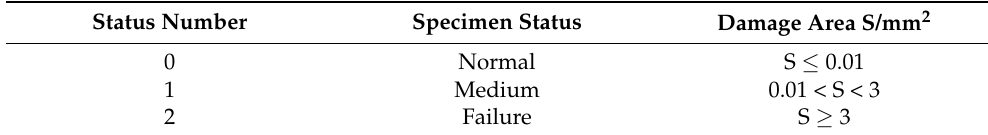
Table 8. The contact fatigue state of the specimen.